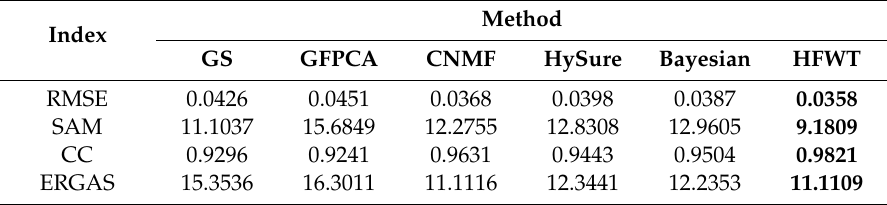
Table 4. Objective quality evaluation of each method for the real dataset. (The best values of each index are marked in bold.)